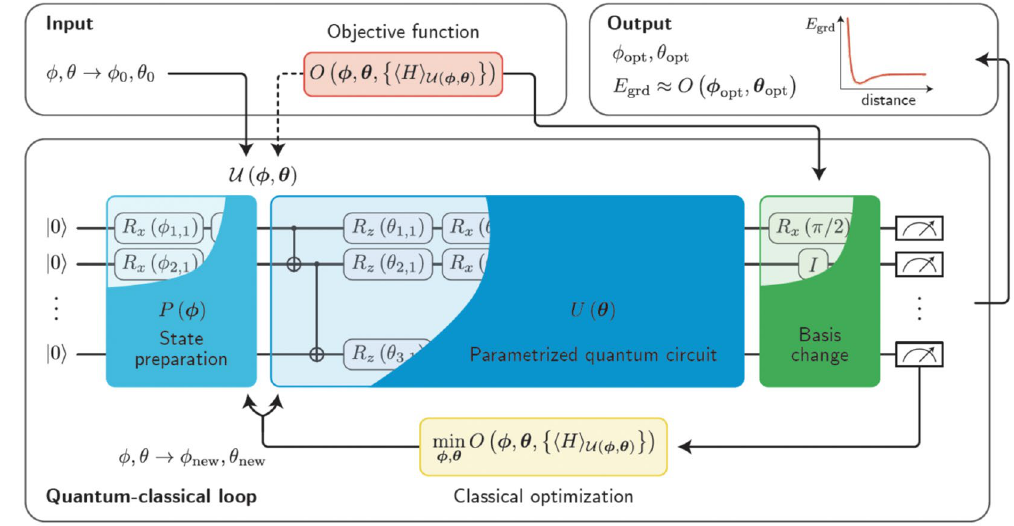
Figure 8. Schematic diagram of a Variational Quantum Algorithm (VQA). Figure is taken from the Ref. 2 .